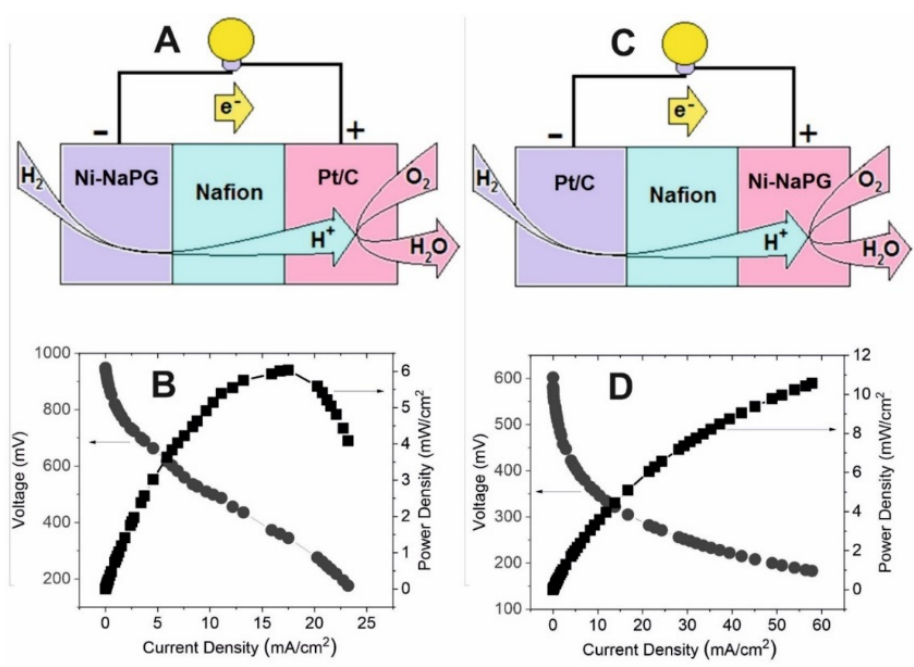
Figure 6. Representations ( A , C ) of the H 2 /O 2 PEMFC and polarization and power curves at 80 °C for MEAs Ni(20%)-NaPG/Nf/Pt ( B ) and Pt/Nf/Ni(20%)-NaPG ( D ).